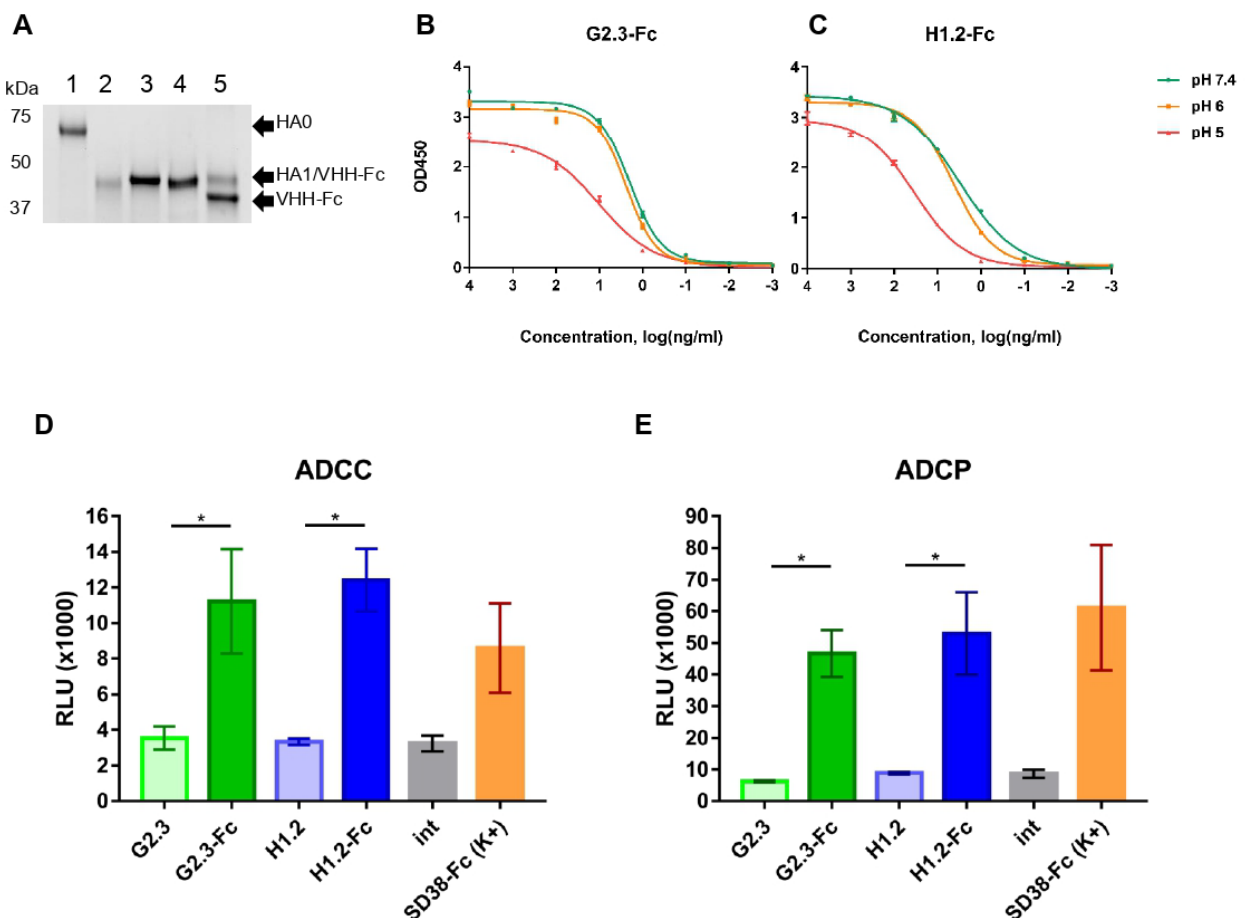
Figure 2. Mechanism of antiviral action of VHH-Fc. ( A ) Cleavage inhibition assay: rFL HA H1 was pre-incubated with VHH-Fc and then cleaved with TPCK-trypsin. 1—rFL HA H1 (~65–67 kDa) under reducing conditions; 2—product of rFL HA H1 tryptic digestion: HA1 (~45 kDa), HA2 band is not visible; 3—rFL HA H1 preincubated with G2.3-Fc, HA1 band overlaps with the single chain of VHH-Fc band due to similar MW; 4—rFL HA H1 preincubated with H1.2-Fc, HA1 band overlaps with the single chain of VHH-Fc band; 5—rFL HA H1 preincubated with control anti-HA single-domain antibody, SD38-Fc, HA1 band separates from the single chain of VHH-Fc band. ( B , C ) ELISA with rFL HA H1 subjected to trypsinization and treated with different pH (citrate buffer pH 7.4, 6 and 5). ( D , E ) Evaluation of Fc-mediated functions, ADCC, and ADCP: the effector cells, featuring CD16 (ADCC, ( D )) or CD32 (ADCP, ( E )) were added to A549 cells, expressing HA A/California/07/2009 (H1N1) protein and previously incubated with 250 nM of VHH or VHH-Fc. ADCC and ADCP activities were expressed as RLU—relative luminescence units. Error bars represent means ± SD. Asterisks indicate significant differences: *, p = 0.0286. int—intact cells.